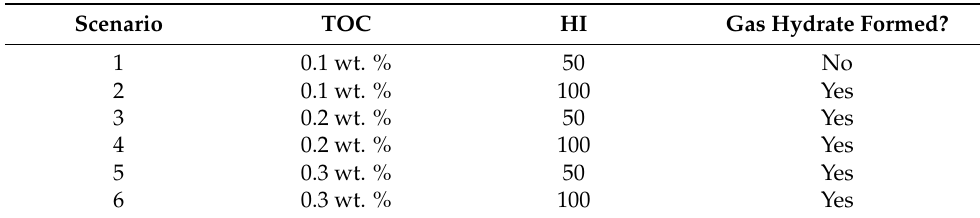
Table 1. Subset of the TOC/HI scenarios tested via our 3-D synthetic modelling, including indication of whether or not these scenarios resulted in gas hydrate